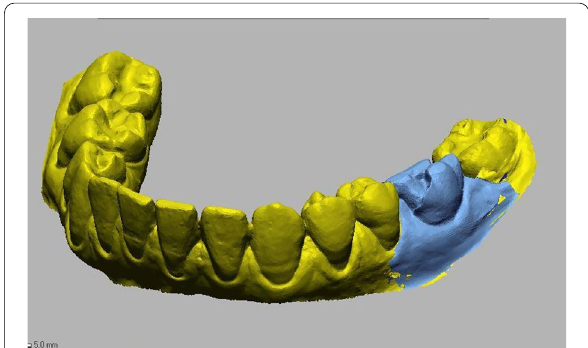
Fig. 5 Buccal view showing the change of the soft tissue volume in a case treated following the spontaneous healing protocol